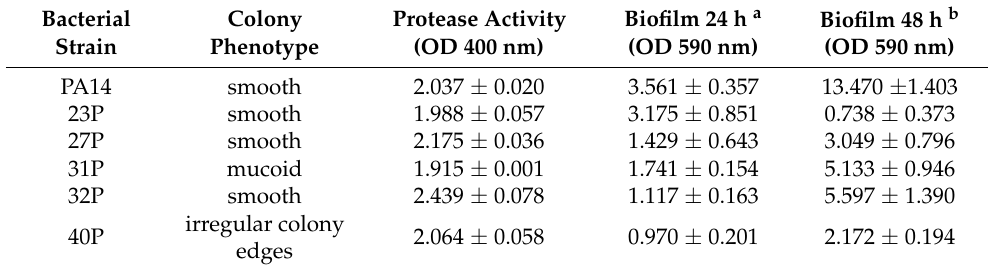
Table 1. Phenotypic characterization of clinical and PA14